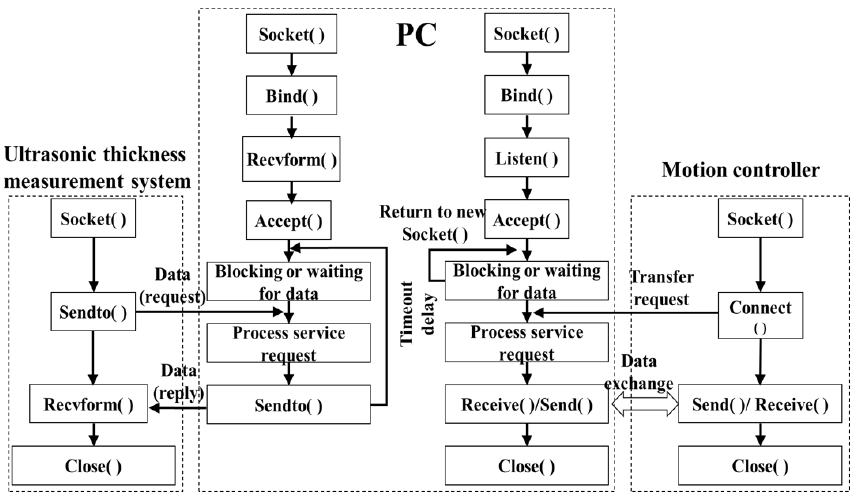
Figure 4. Communication flow chart of the upper computer and robot motion controller system communication scheme.